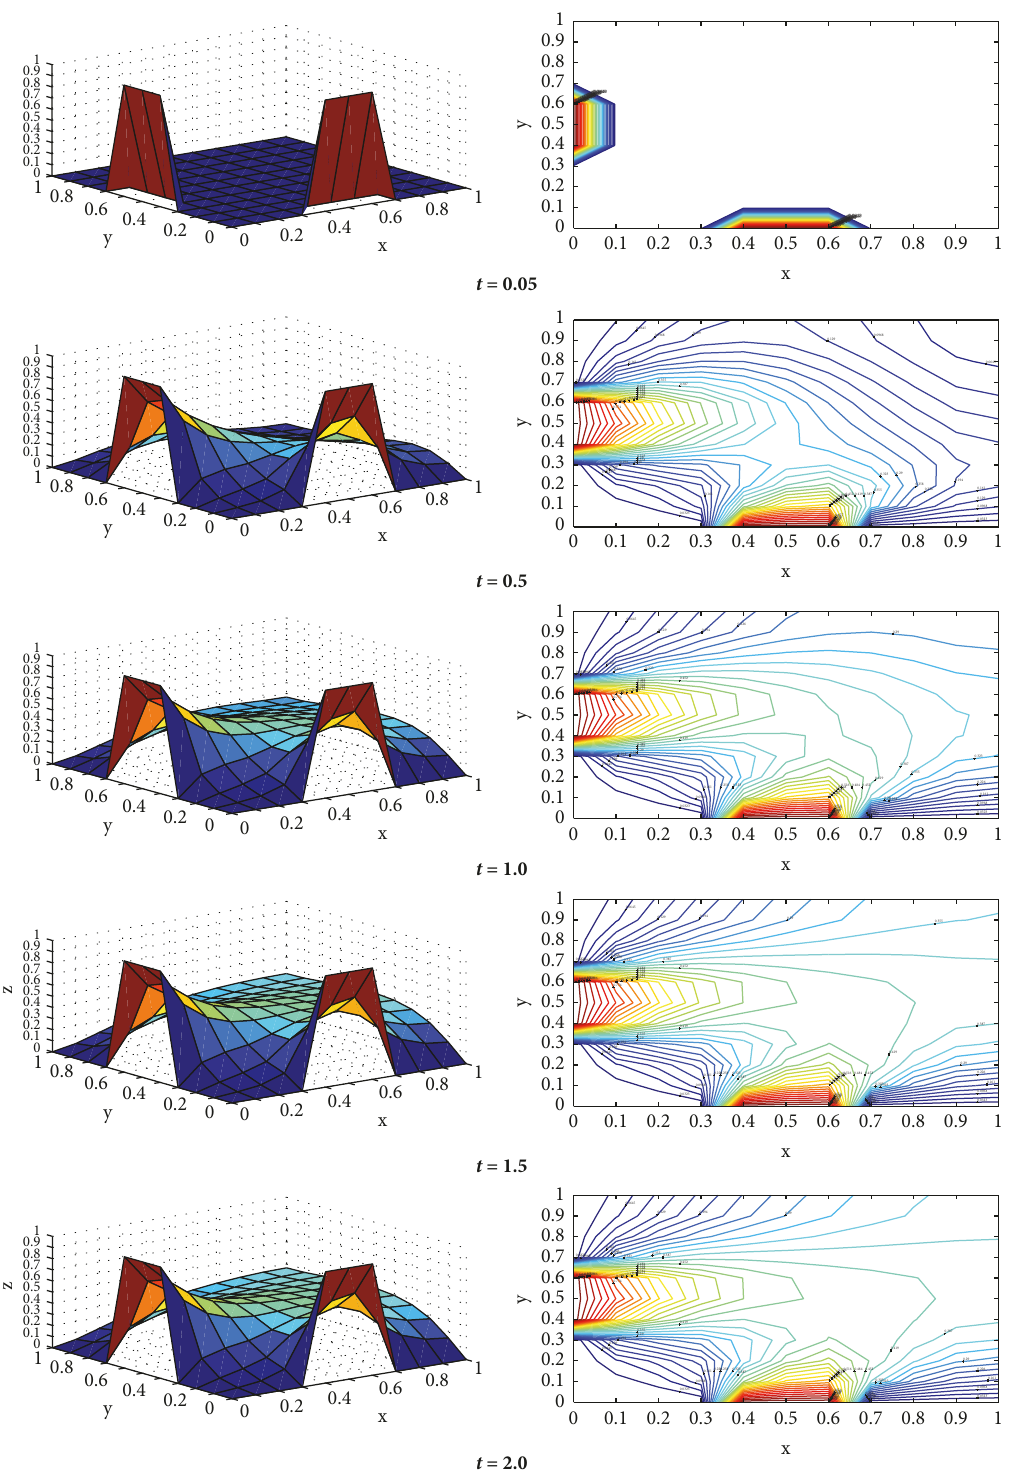
Figure 4: Pollutant distribution in a box model under the sea with advection in 𝑥 , 𝑦 , and 𝑧